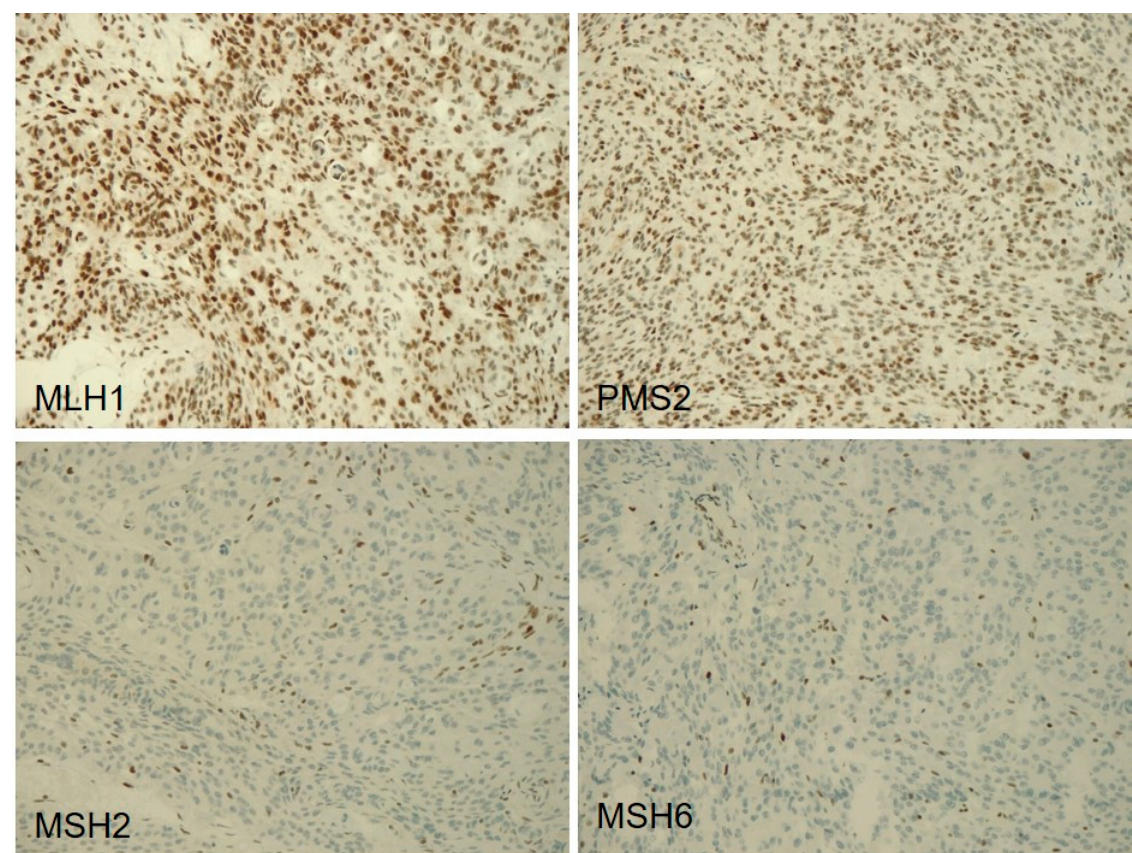
Figure 2. Immunohistochemistry for mismatch repair (MMR) proteins in a meningioma with MSH2 mutation. Nuclear expression of MLH1 and PMS2 was retained in the neoplastic cells of meningioma, while that of MSH2 and MSH6 was lost in the neoplastic cells and retained in non-neoplastic cells (original magnification, ×200).